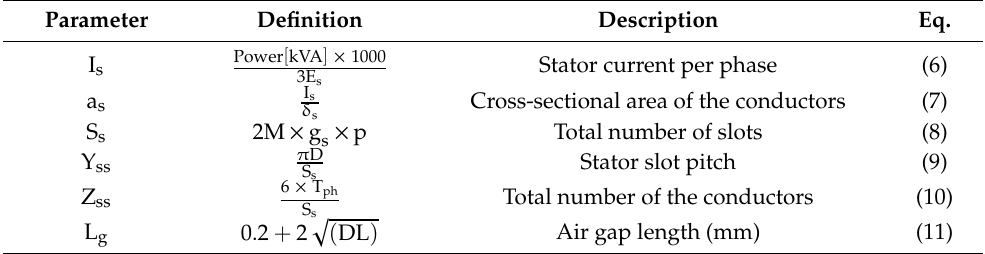
Table 2. Definition of the stator